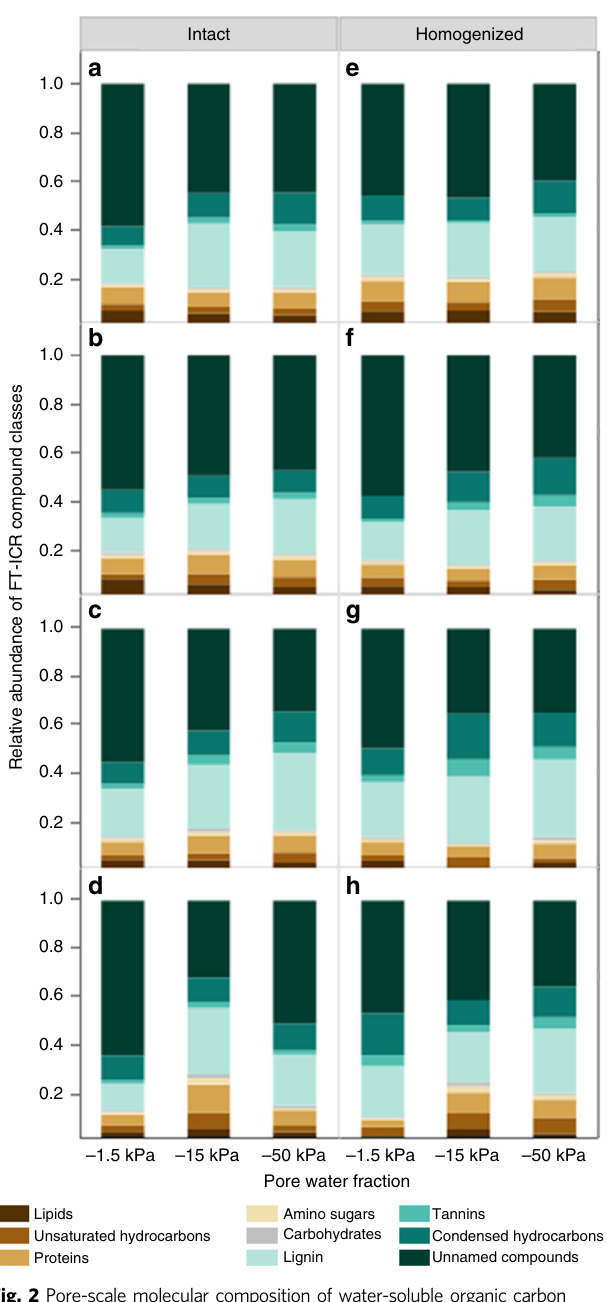
Fig. 2 Pore-scale molecular composition of water-soluble organic carbon collected after rewetting incubation from different pore size suction